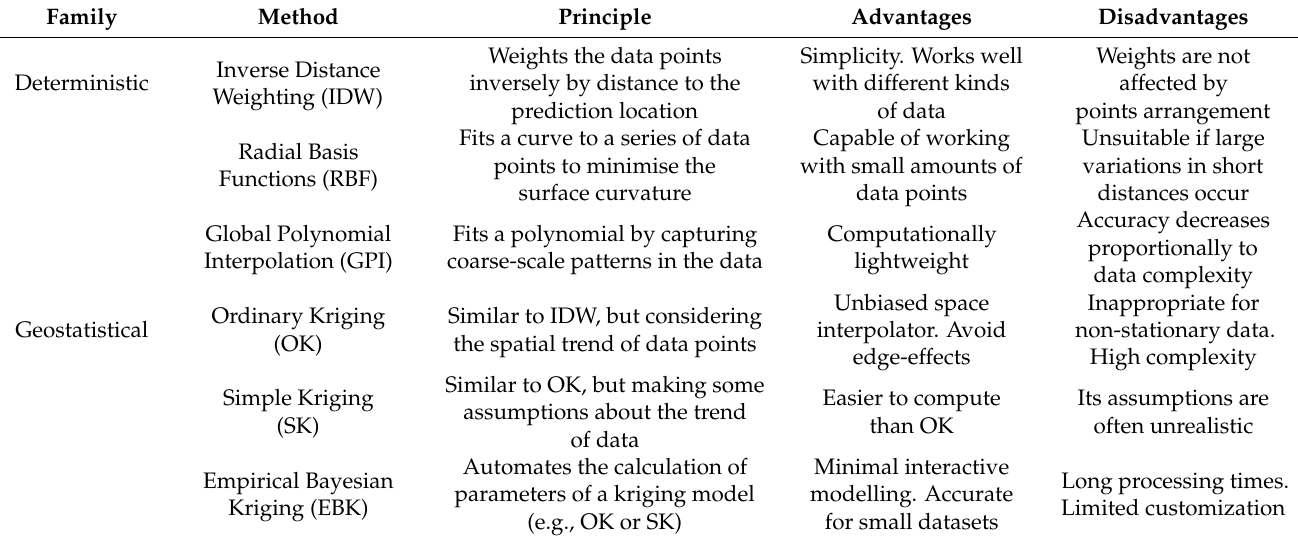
Table 1. Main features of the interpolation methods